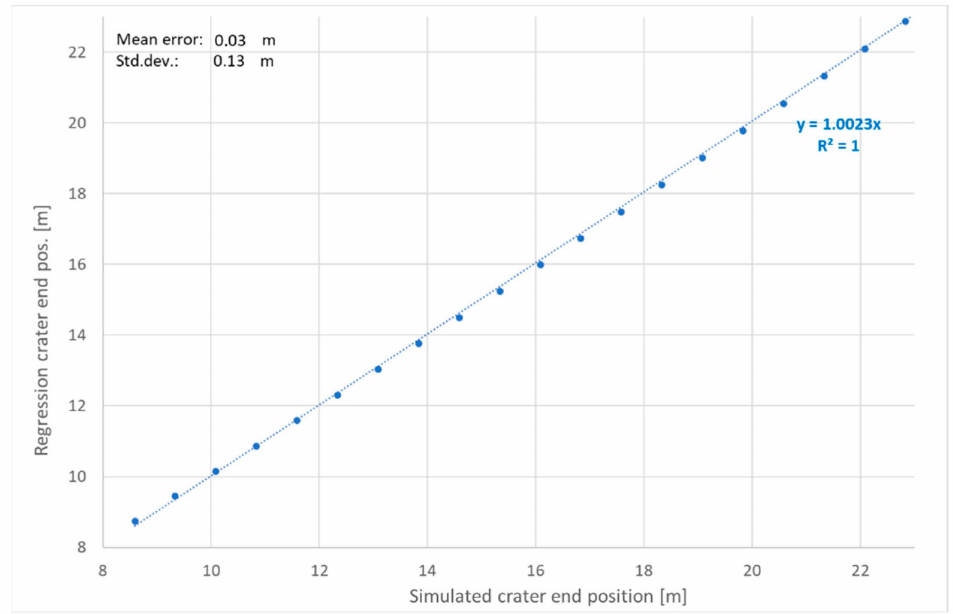
Figure 18. Crater end position from regression Formula (7) vs. crater end position from online model simulation for sequence casted at